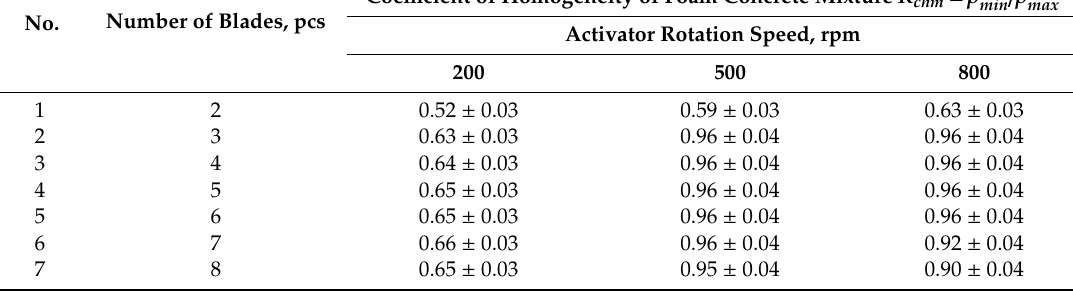
Table 2. Dependence of the homogeneity coefficient of foam concrete mixture on the change in the number of activator blades and rotation speed.